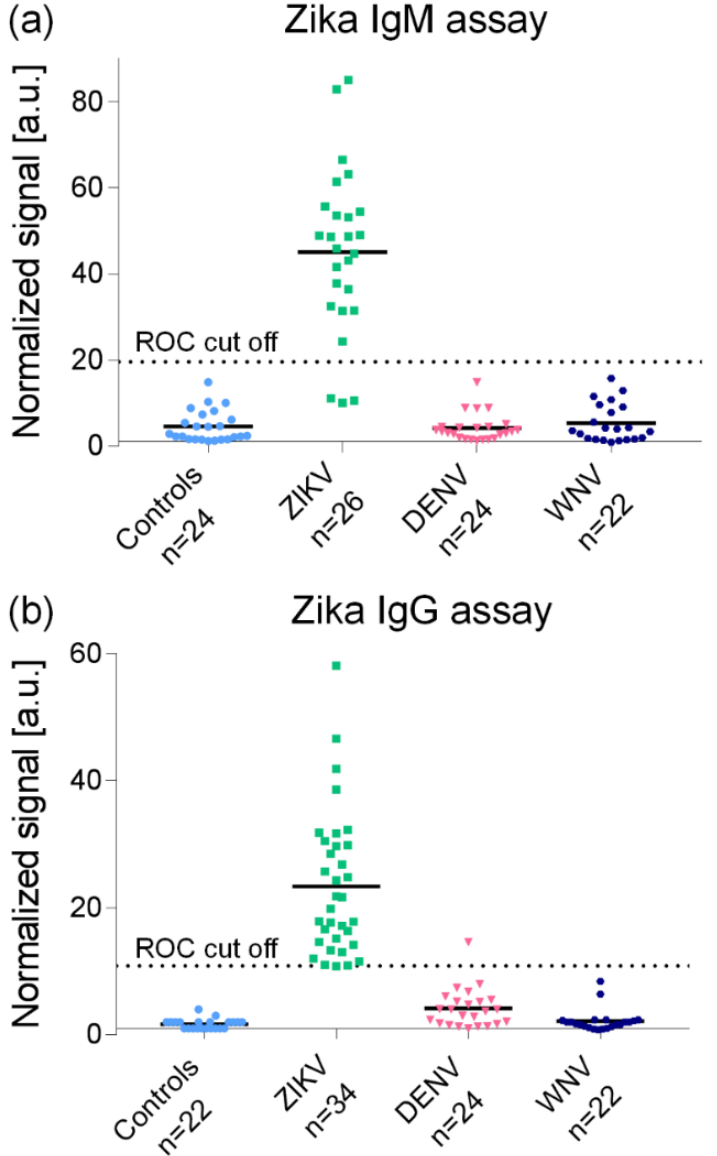
Figure 4. Sensitivity, specificity, and cross-reactivity of the MMB Zika IgM and IgG serological assays. ( a ) Zika IgM and ( b ) Zika IgG assay results. The Controls (blue) were taken from healthy patients. The DENV (red) and WNV (black) are Dengue virus (DENV)- and West Nile virus (WNV)-positive samples were taken from enzyme-linked immunosorbent assay-positive patients. All samples were obtained from the National Center for Zoonotic Viruses at the Central Virology Laboratory of the Ministry of Health at Sheba Medical Center, Israel. The ZIKV (green) are Zika Virus positive samples taken from quantitative reverse-transcription polymerase chain reaction/neutralization-positive patients. The IgM and IgG samples were obtained on days 1–60 and 7–180 post-symptom onset, respectively. The Zika-positive samples were collected from Israeli travelers presenting at the Institute of Tropical Medicine at Sheba Medical Center after returning from Zika-endemic areas. The MMB IgM assay detected 23 of 26 Zika-positive samples (88% sensitivity), and the MMB IgG assay detected 33 of 34 Zika-positive samples (97% sensitivity) The specificity of the MMB assay for both IgM and IgG was 100%. The cross-reactivity to WNV was 0% for both IgM and IgG. The cross-reactivity to DENV was 0% for IgM and 4% for IgG. Reprinted from [20] by permission of Oxford University Press 2018.